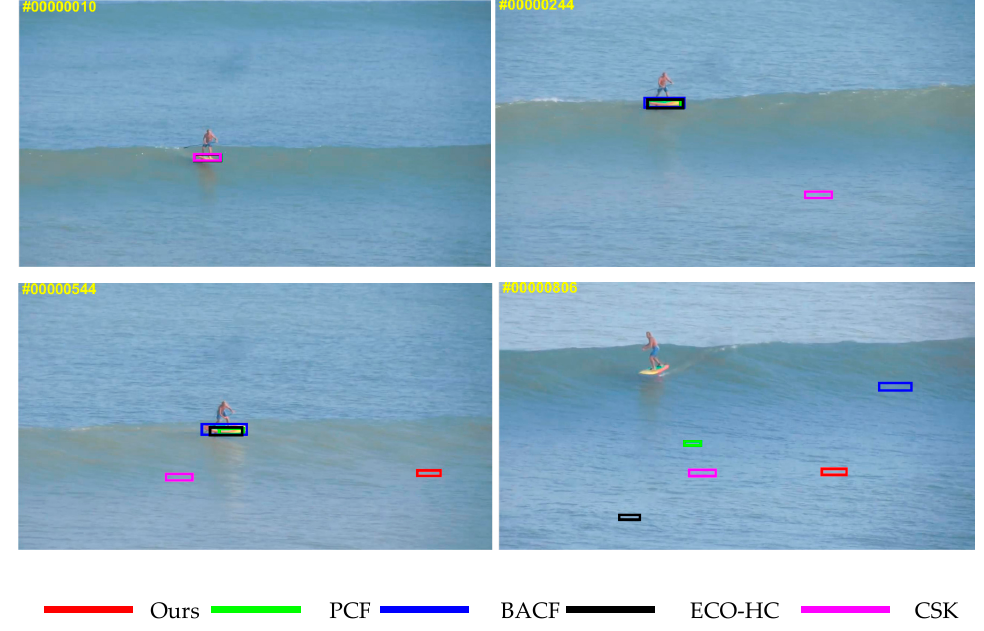
Figure 8. Failure case of proposed tracker on complex marine environmental objects. The results for representative five trackers are expressed in di ff erent